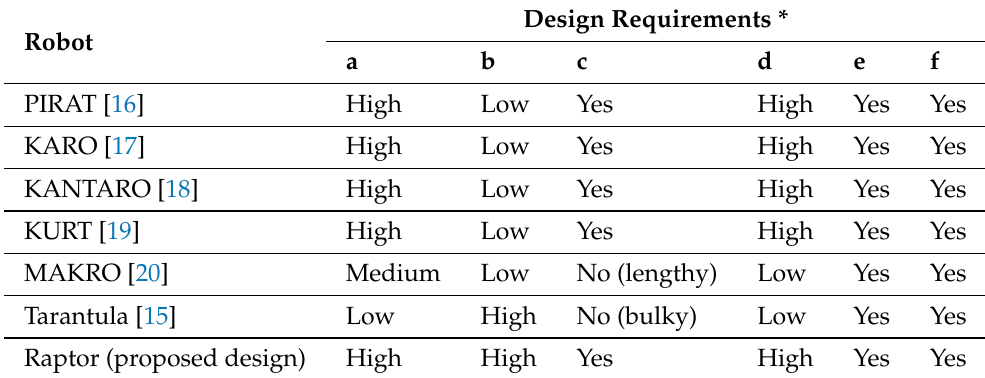
Table 1. Comparison of the proposed design with the existing drain inspection